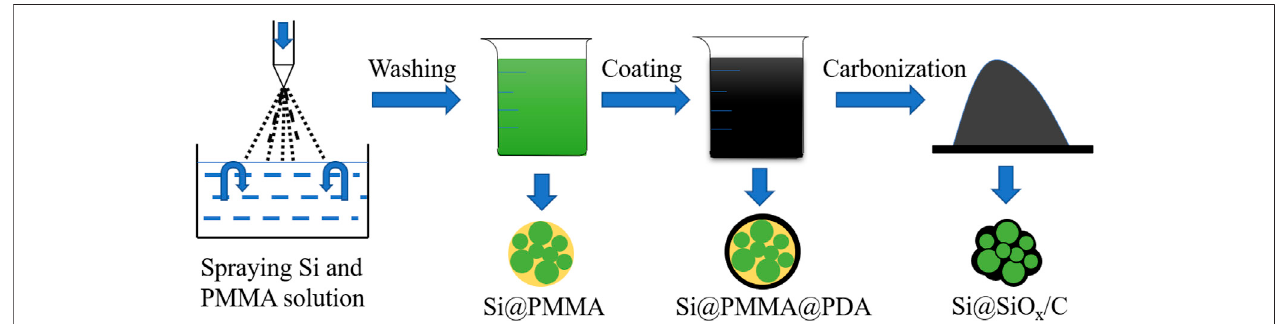
FIGURE 1 | Flow diagram of preparation of Si@SiO x /C anode material by spray and pyrolysis